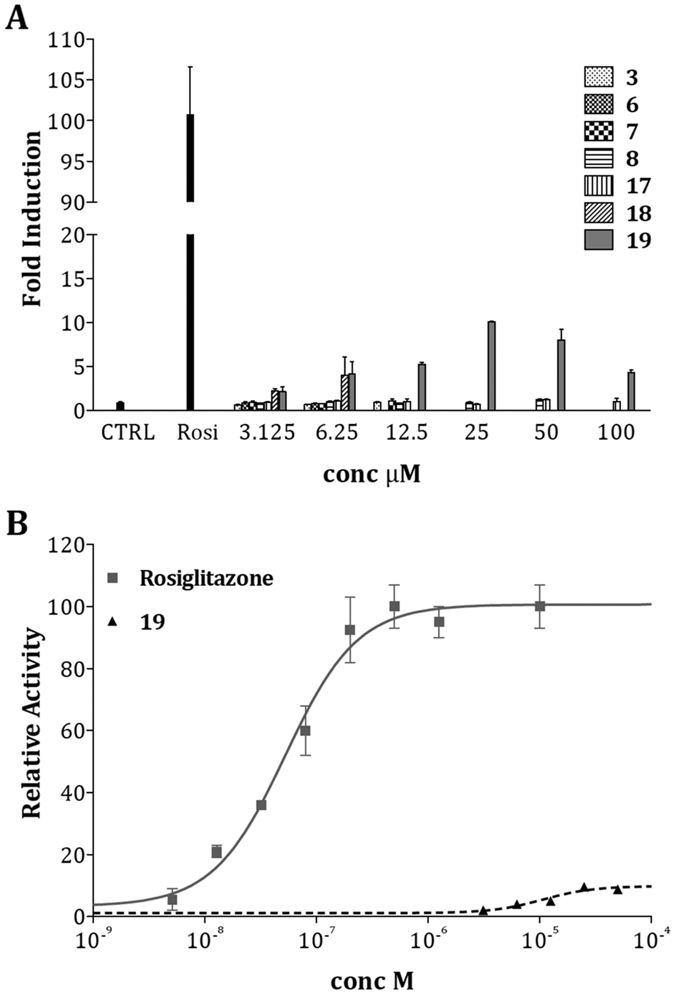
(A) PPARγ activity from saponins/sapogenins showing higher affinities (Rosi corresponds to the reference compound rosiglitazone); (B) Dose-response curve on PPARγ from rosiglitazone and sapogenin 19.